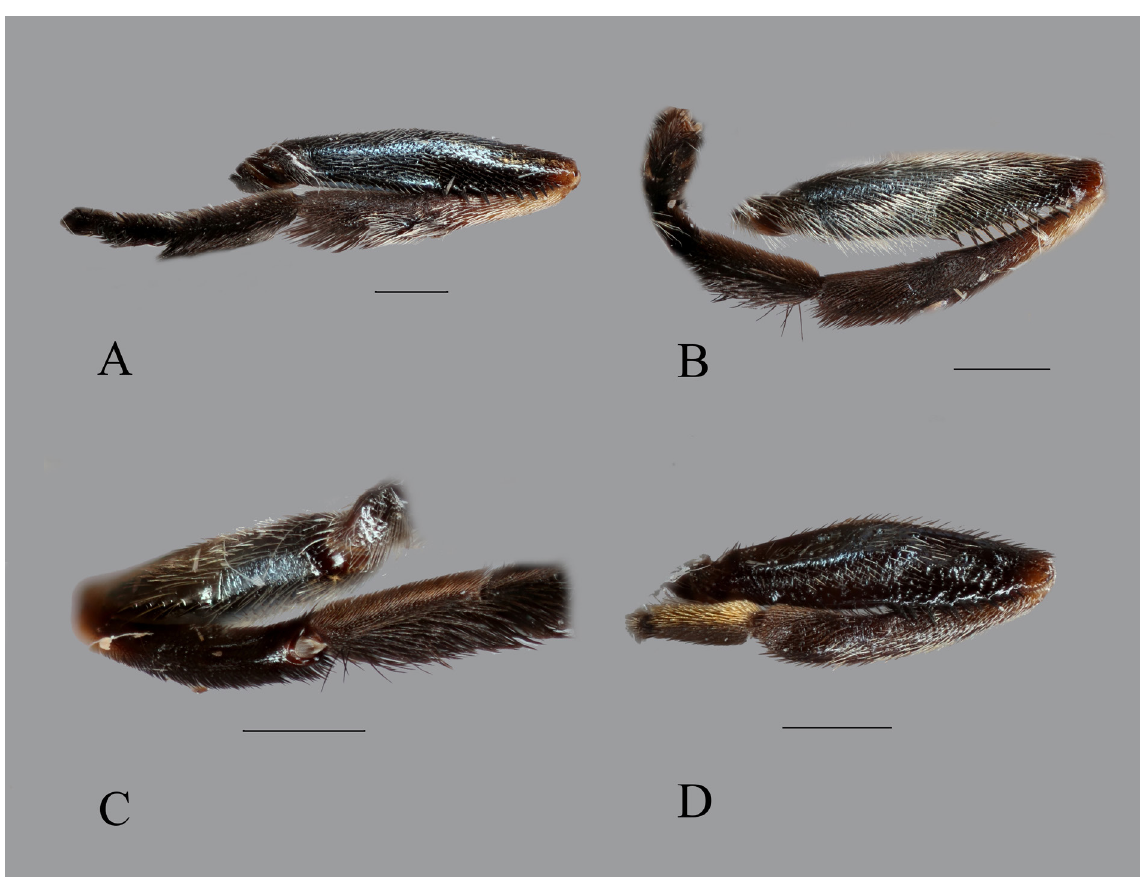
Fig. 10. Metaleg, ♂, lateral view. A . Eumerus kazanovzkyae Paramonov, 1927, Paveh, Iran (HMIM). B . E. pilosipedes Gilasian & van Steenis sp. nov., holotype (HMIM). C . E. pilosipedes Gilasian & van Steenis sp. nov., details of tarsus, holotype (HMIM). D . E. vallicolus Gilasian & van Steenis sp. nov., holotype (HMIM). Scale bars = 0.5